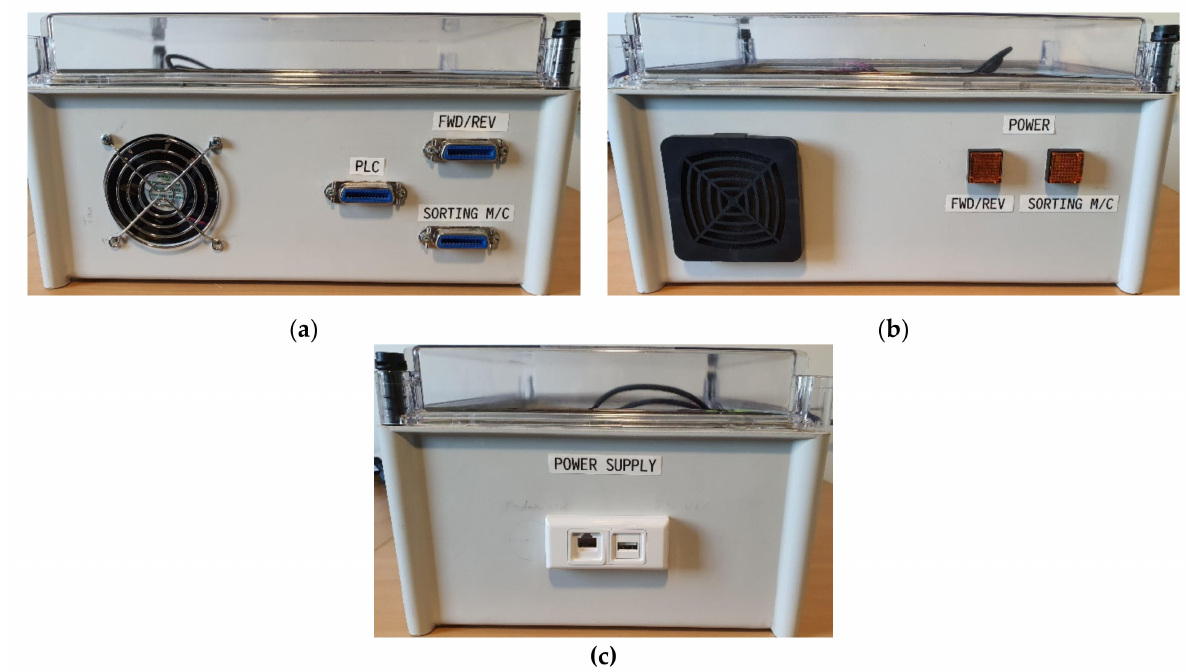
Figure 18. Side views of the final control box. ( a ) Centronics cable connections and exhaust fan; ( b ) Indicator lamps for experiment selection and air inlet vent; ( c ) Power supply connections—USB for micro-controller, and ethernet for relay controls to power supply box.